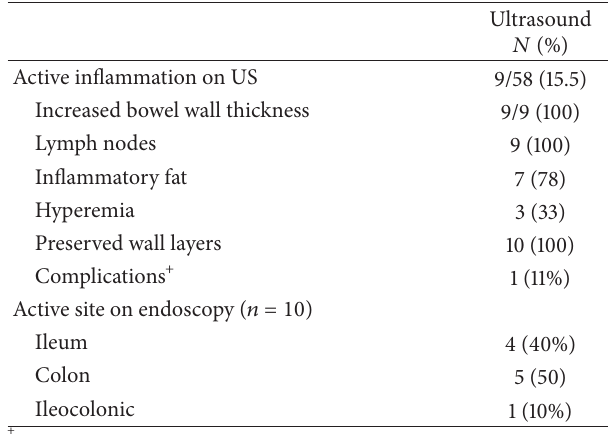
Table 1: Patient demographic and laboratory investigation data Table 2: Descriptive ultrasonographic and endoscopic data.